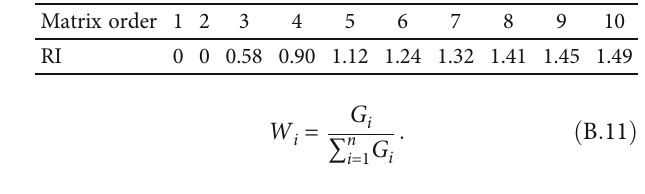
Table 30: Consistency index